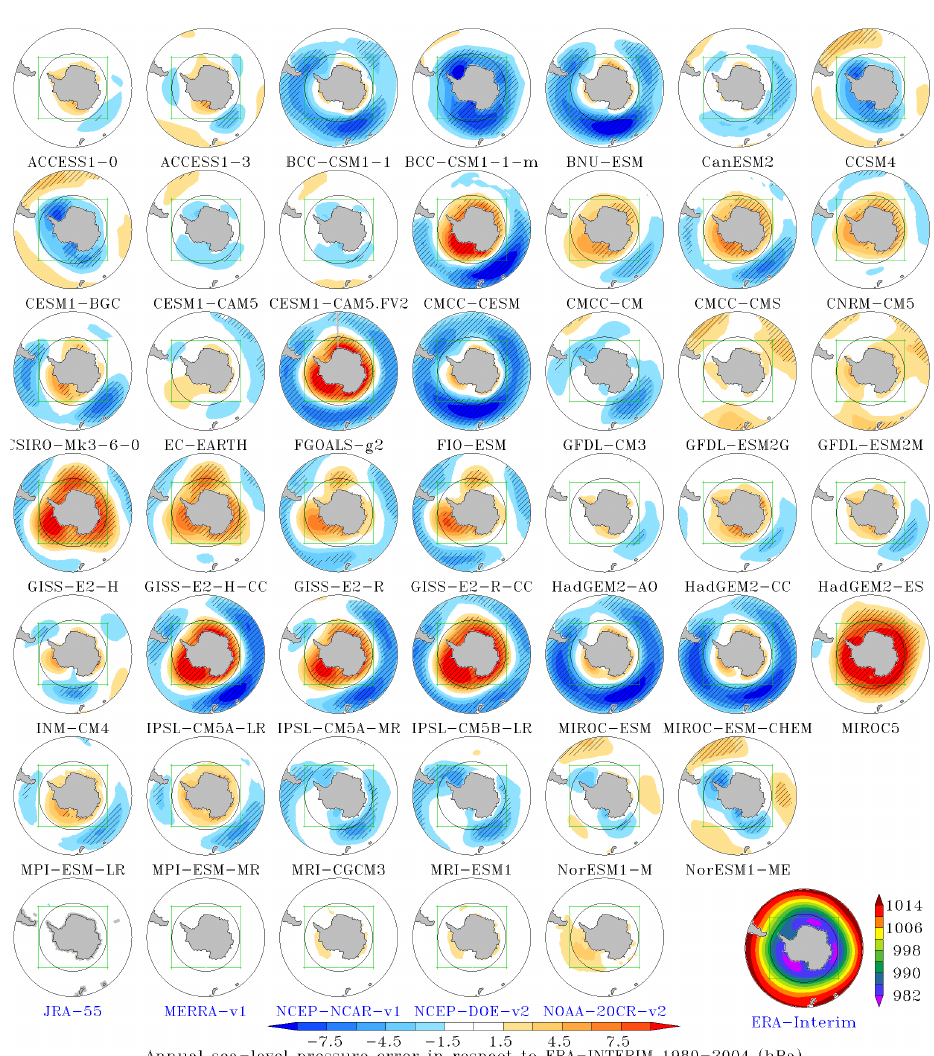
Figure 1. Mean differences of sea-level pressure between models and ERA-Interim over the period 1980–2010 (in hPa). CMIP5 model names are in black, and reanalysis names are in blue. Hashes are for areas where the difference is higher that 2 times the ERA-Interim annual sea-level pressure standard deviation over the same period. External circle is 40 ◦ S, and intermediate black circle is 60 ◦ S. Green rectangle is a typical domain boundary for regional climate models over Antarctica (e.g. Ligtenberg et al., 2013). ERA-Interim sea-level pressure over the period 1980–2010 is displayed in the low-right panel (in